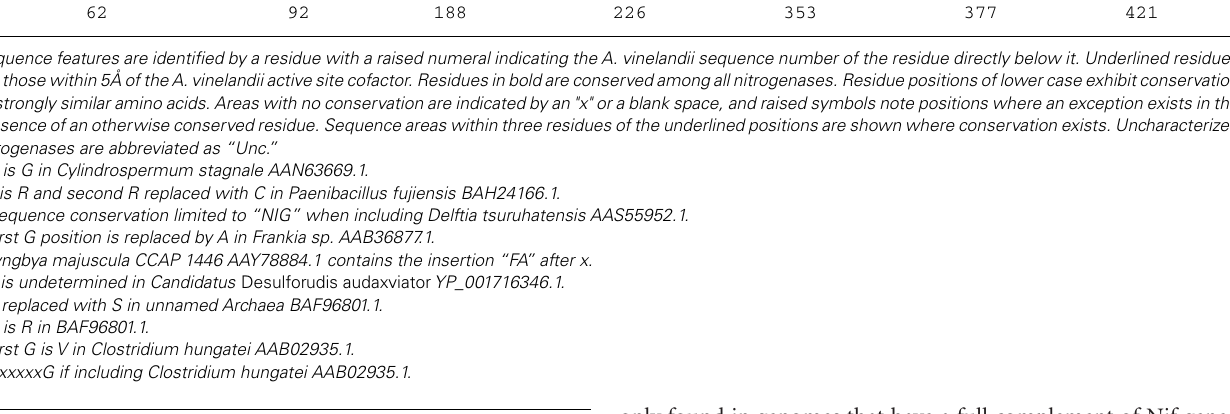
Table 3 |Average active site cofactor volume ( n = 3 in each case) for nitrogenases computed by the CASTp server in the absence of the active site